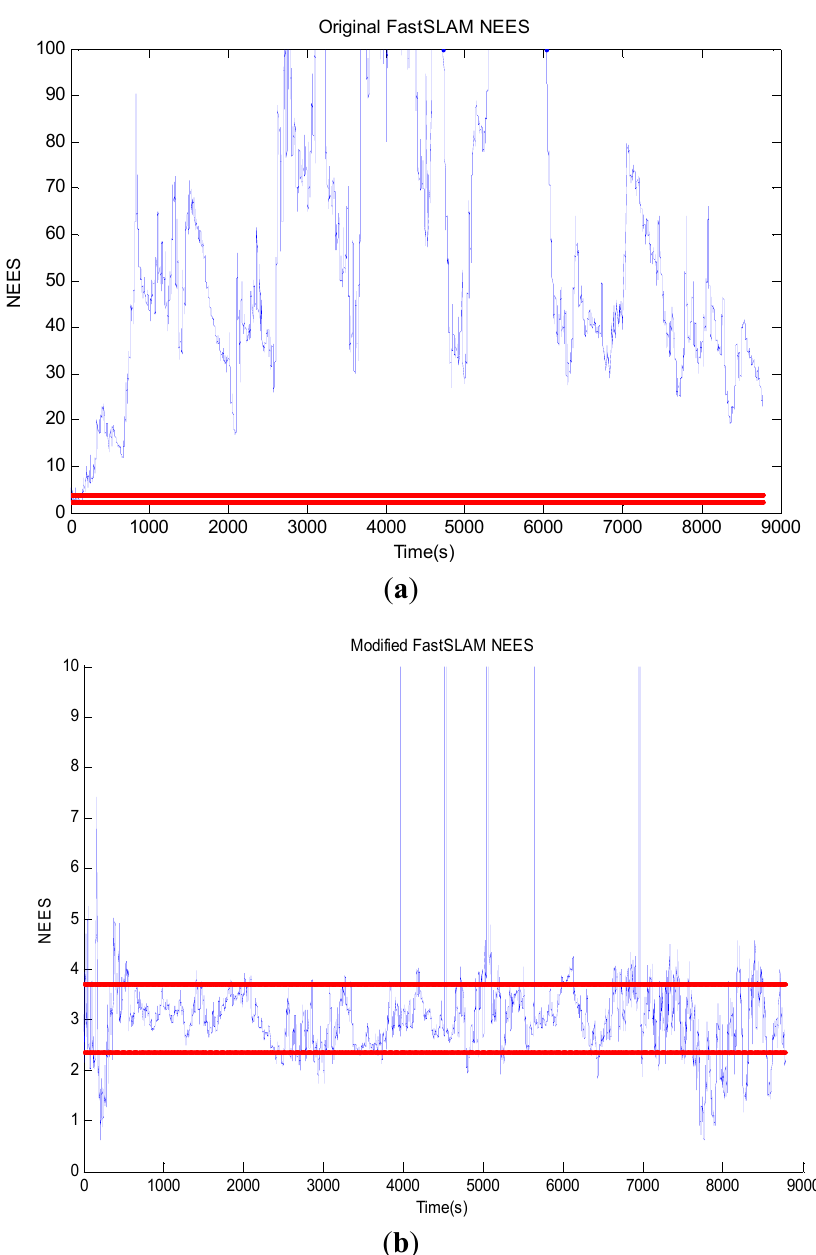
Figure 9. Average NEES of the two